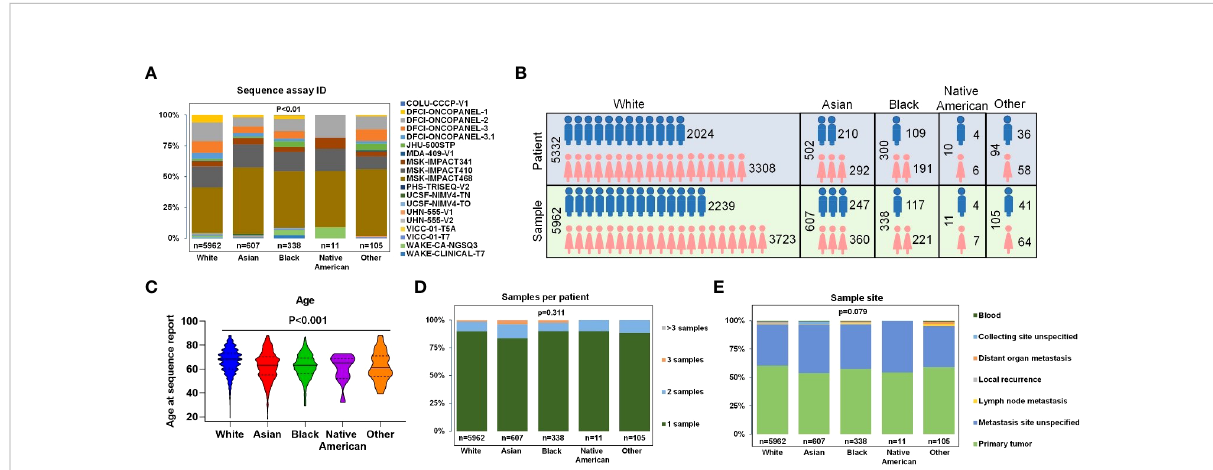
FIGURE 2 Clinical characteristics of all patients and samples. (A) Percentage of gene panels (number of gene >=275) selected for subsequent data analysis. (B) Patients and samples divided by sex of White, Asian, Black, Native American, and Other. (C) Age at sequence report. (D) The number of samples per patient. (E) Sample sites of each race.